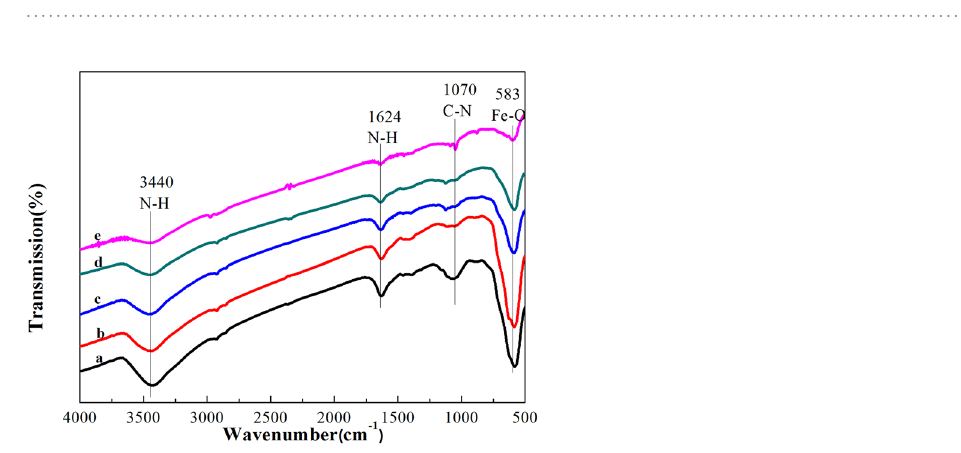
Figure 5. Photographs: (a) Fe 3 O 4 –NH 2 in water, (b) Fe 3 O 4 –NH 2 being pulled by magnet, (c) Fe 3 O 4 –NH 2 –Pd in water, (d) Fe